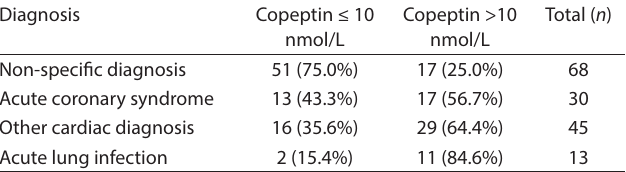
Table 2. Diagnosis at discharge from the hospital in patients who were admitted to a ward.